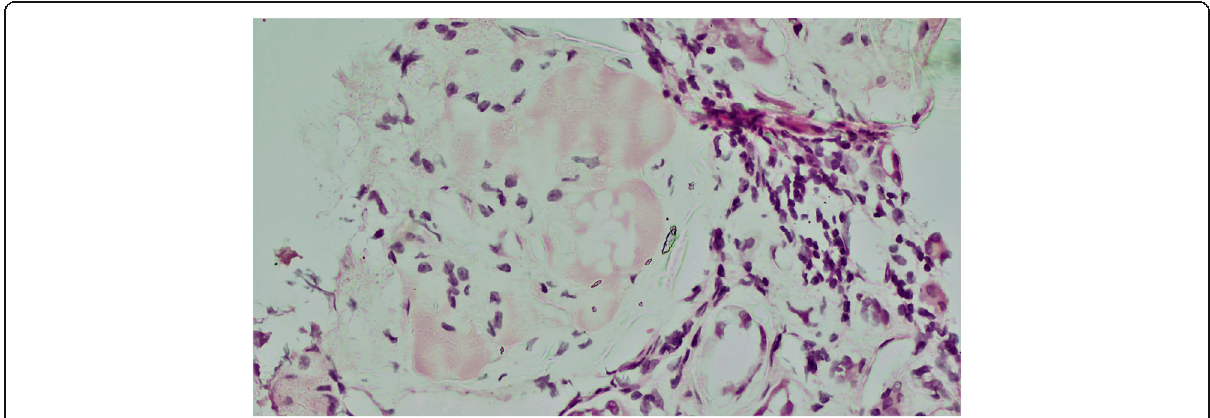
Fig. 5 Renal microphotograph showing ovoid, eosinophilic nodules in mesangium characteristic of diabetic nephropathy(H&E,